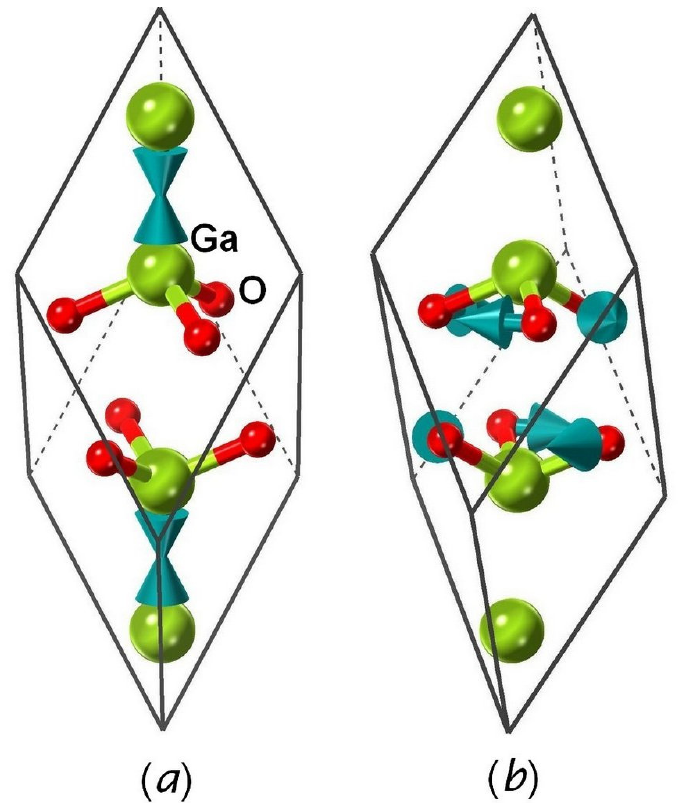
Figure 16. Directions and relative amplitudes of oscillation of atoms in α -Ga 2 O 3 , as calculated within the DFT framework for lines of the Raman spectrum A 1g,1 ( a ) and A 1g,2 ( b ). Only one primitive cell is shown; z-axis is oriented upwards. Large green balls represent Ga atoms; small red balls represent O atoms.